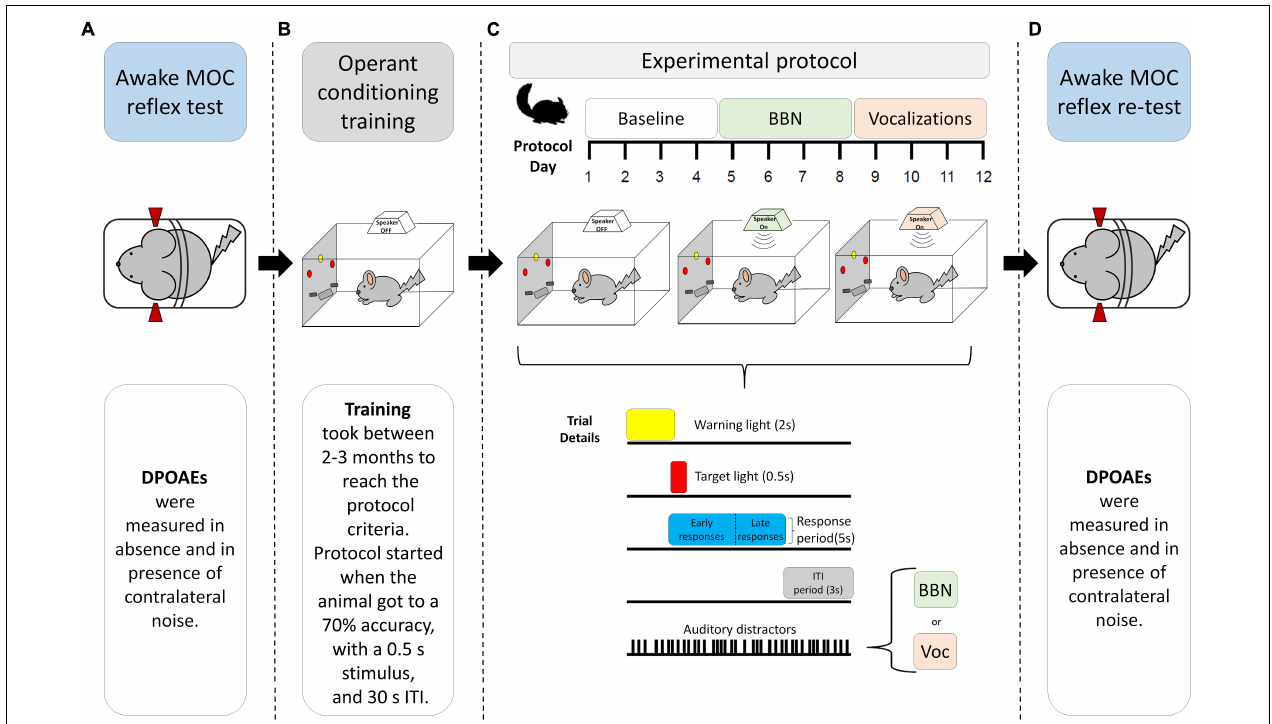
FIGURE 1 | Experimental design diagram. The image schematizes the experimental tests to which the animals were subjected. First, the MOC reflex was evaluated in awake chinchillas with restricted mobility (A) . After the evaluation, training of the visual attention task was started in the operant conditioning apparatus (B) . After 2–3 months of training, the animals moved to the 12-day experimental protocol (C) , where they performed the task in silence and in the presence of auditory distractors (BBN and Chinchilla vocalizations). The time course of the visual discrimination task can be seen at the bottom of panel (C) . The task began with a central warning light (2 s), followed by the presentation of a side light (0.5 s) indicating which response lever was the target of that trial. The sidelight also initiated the response time (5 s) for the animal to press the lever and receive a reward. The last 3 s shown in the diagram corresponded to part of the ITI-time response period, where the animal did not receive a reward if it pressed the lever. Finally, at the end of the 12-day protocol, the MOC reflex of the Chinchillas was measured again (D)